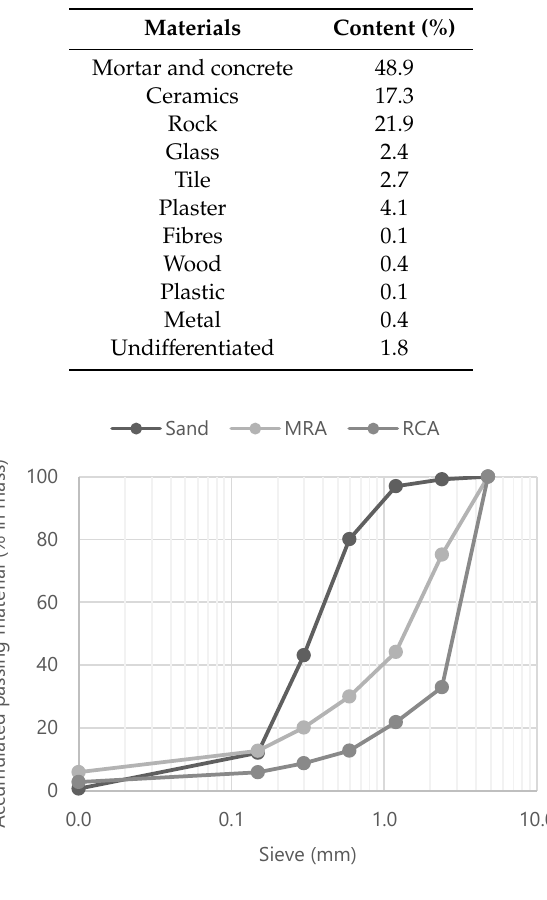
Figure 1. Size grading curve of the aggregates. Table 4. Composition of the mortar’s mixes (kg / m 3